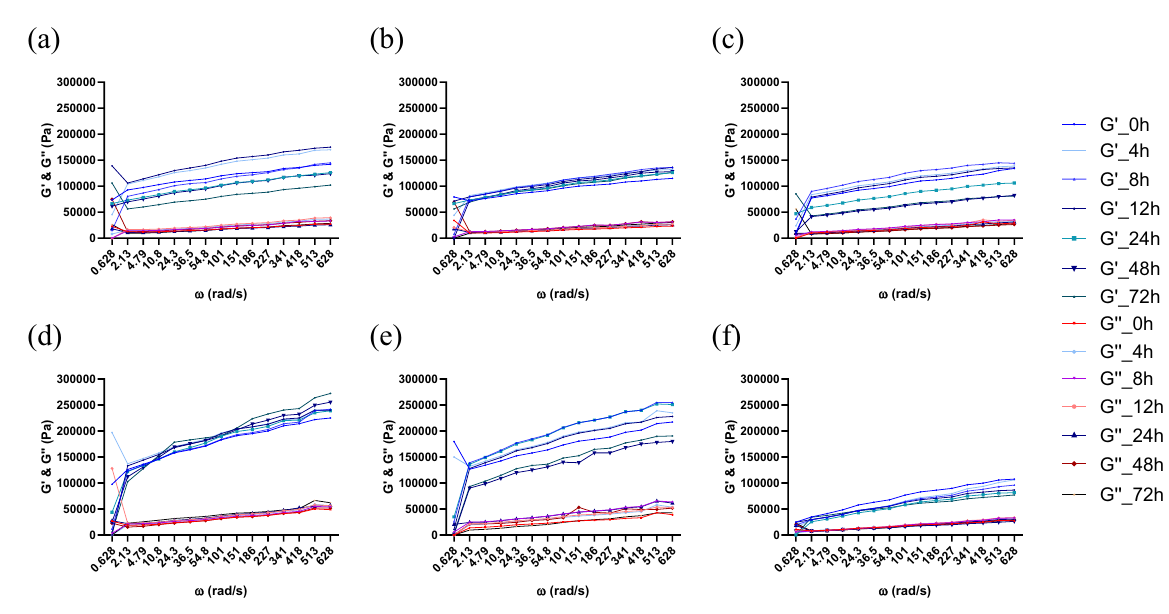
Figure 3. Rheological properties during the fermentation process and frozen storage with S. cerevisiae. Fermentation influence ( a ) SP10; ( b ) SP5; ( c ) SP0; and after frozen storage ( d ) SP10; ( e ) SP5; ( f ) SP0 (SP0—0% soy powder, SP5—5% soy powder, SP10—10% soy